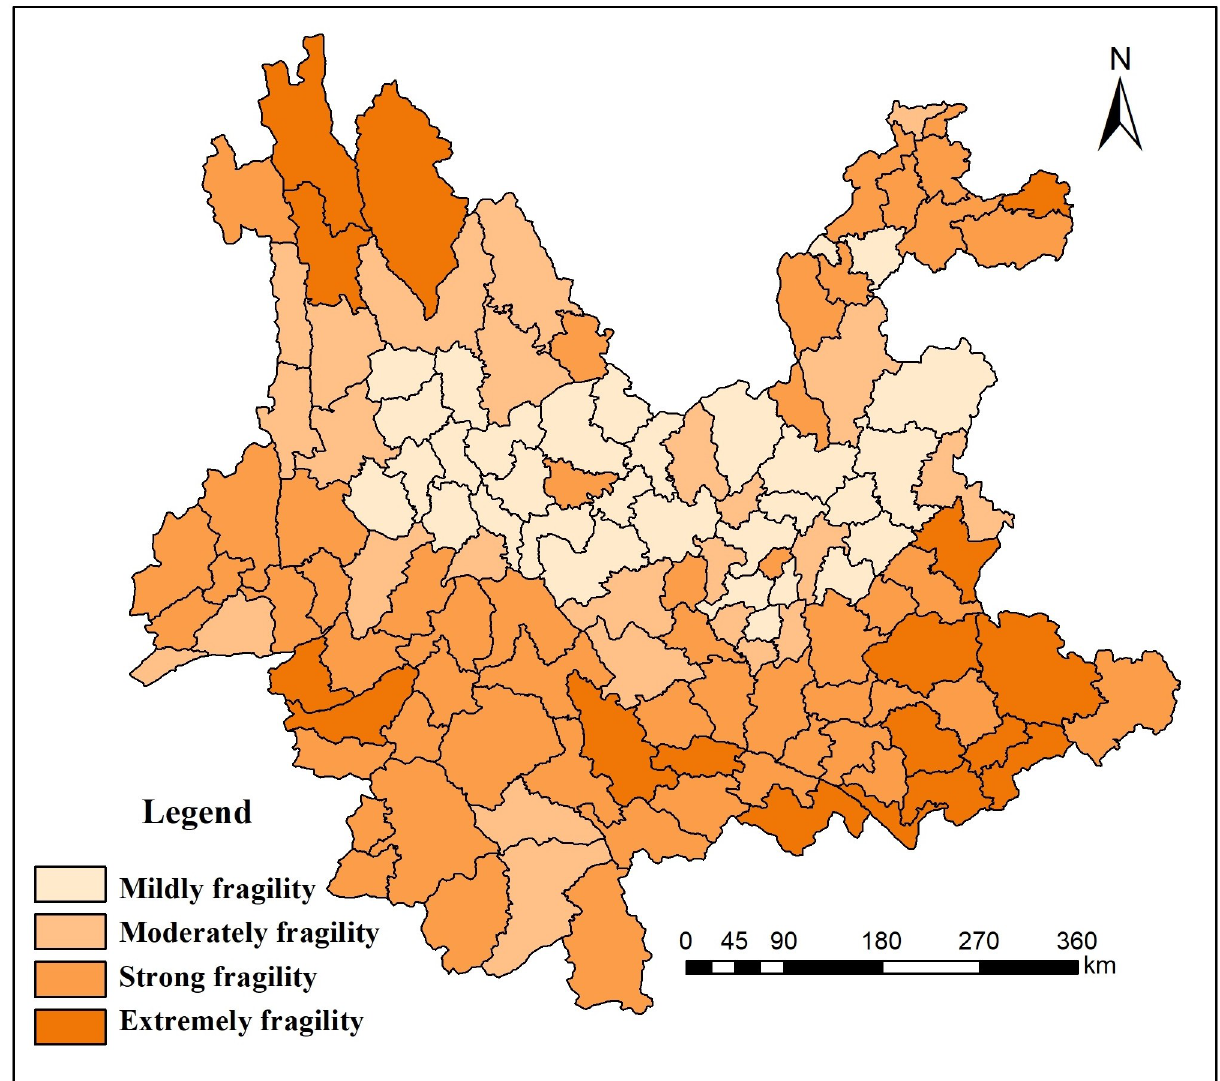
Fig 3. Ecological environment fragility assessment map of Yunnan Province.